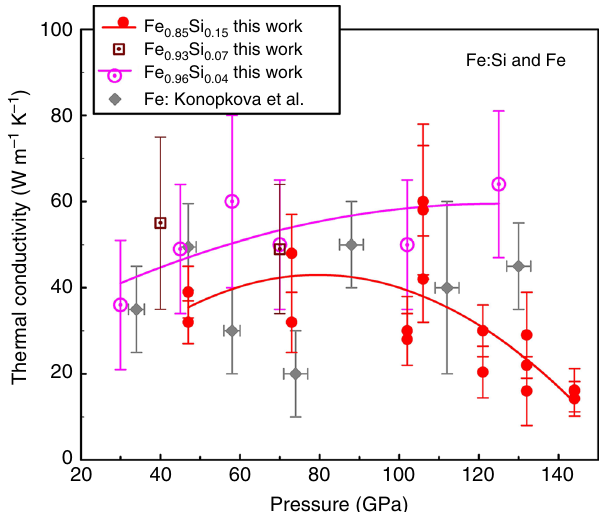
Fig. 2 High-pressure thermal conductivity of Fe – Si alloys at 2050 – 3300 K. Red and magenta curves are guides to the eye. Literature data for Fe at comparable high P – T conditions from ref. 20 are plotted for comparison. Our results are representative of measurements with different laser powers, each corresponding to an averaging of usually 100 laser heating events using a streak camera 20,32 . The measurement uncertainties are typically ≈ 15 – 30%. Effects of temperature on the thermal conductivity of Fe 0.85 Si 0.15 alloy are shown in Supplementary Fig. 4. Pressure – temperature conditions for each measurement are listed in Supplementary Tables 1 – 3.